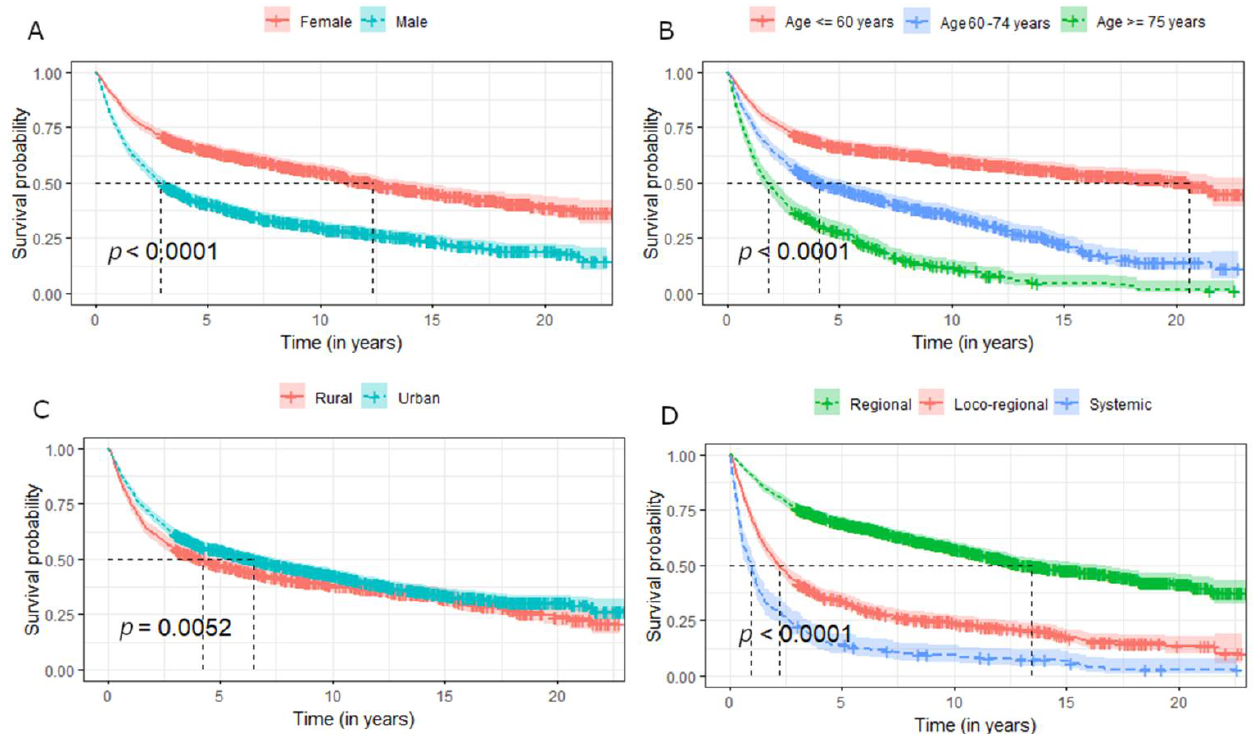
The Kaplan–Meier curves presenting OS in patients with parotid cancers were strati- fied by demographic factors, stadium, histology, and treatment modality (Figures 2–4).